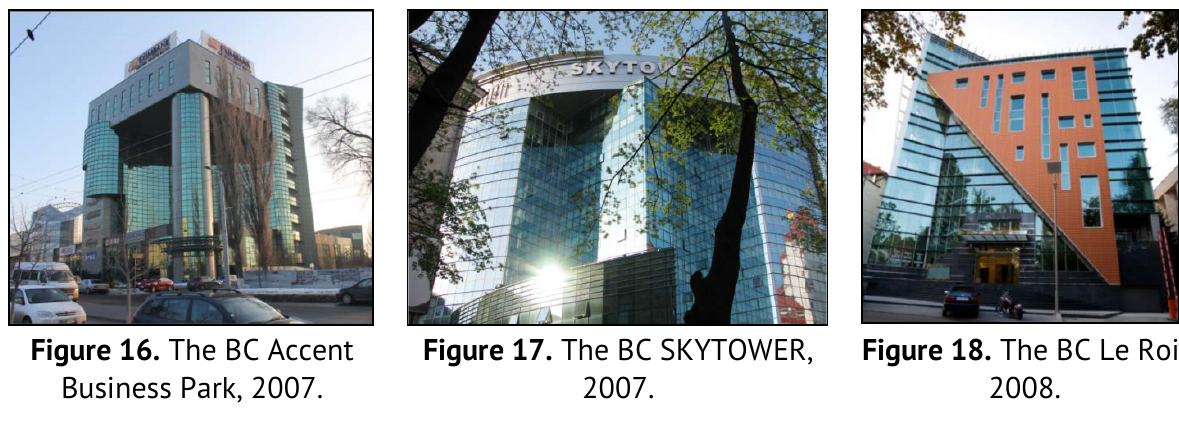
Figure 17. The BC SKYTOWER, 2007.